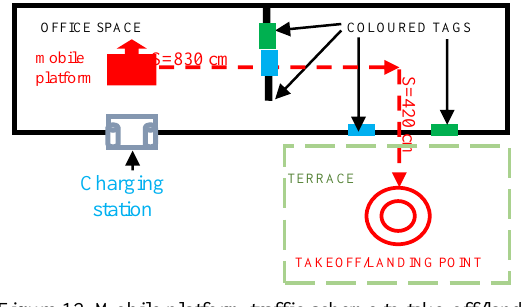
Figure 12. Mobile platform traffic scheme to take-off/landing point 3. EXPERIMENT This complex was used to monitor the territory of 1 sq km. (400